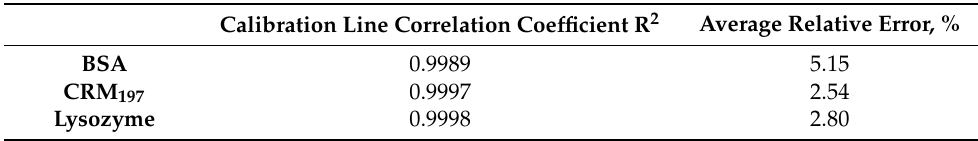
Table 4. Correlation coefficients and average relative errors of the UV-Vis calibration curves used for quantification of BSA, CRM 197 and lysozyme.